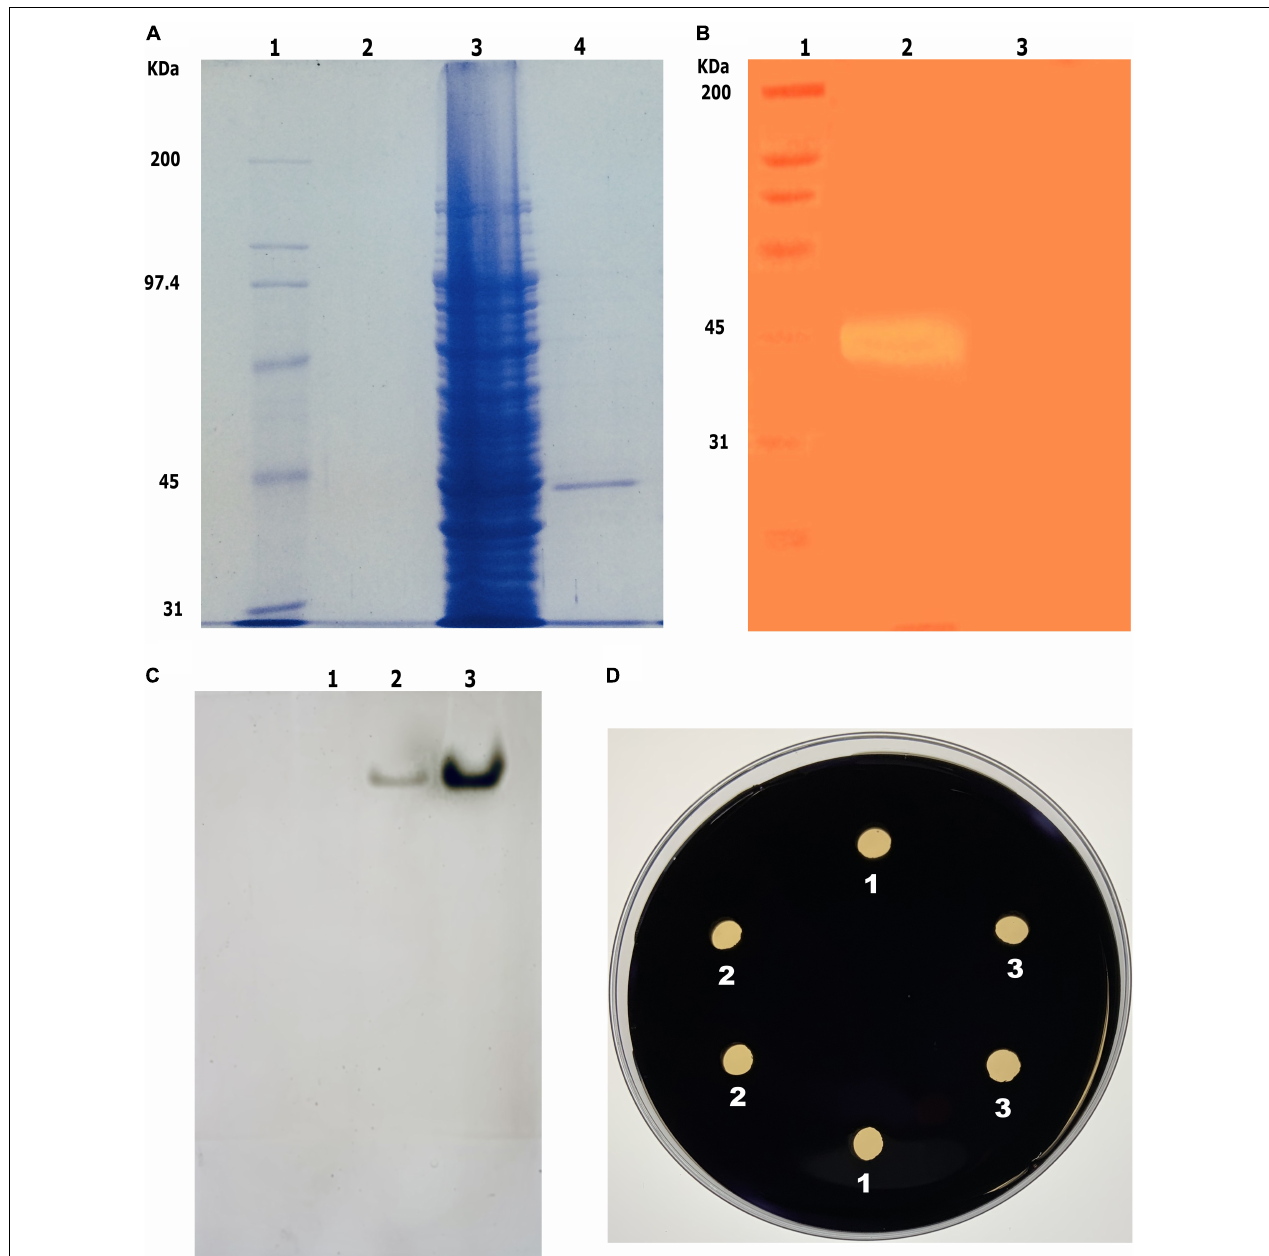
FIGURE 5 | Purification, zymogram, and activity analysis of R13 Fae. (A) Purification of recombinant R13 Fae. Line 1, MW protein standard; line 2, non-induced soluble fraction medium; line 3, total protein extracts of transformed E. coli BL21/pET38b(+)/ r13 fae ; line 4, R13 Fae purified. (B) Zymogram of R13 Fae in 10% SDS-PAGE with 2% beechwood xylan. Line 1, MW protein standard; line 2, xylanolytic activity band of R13 Fae. (C) Activity of R13 Fae on α -naphthyl acetate in 10% native-PAGE. Line 1, non-induced soluble fraction medium; line 2, R13 Fae dialyzed; line 3, R13 Fae purified. (D) Activity of R13 Fae on starch on 1%